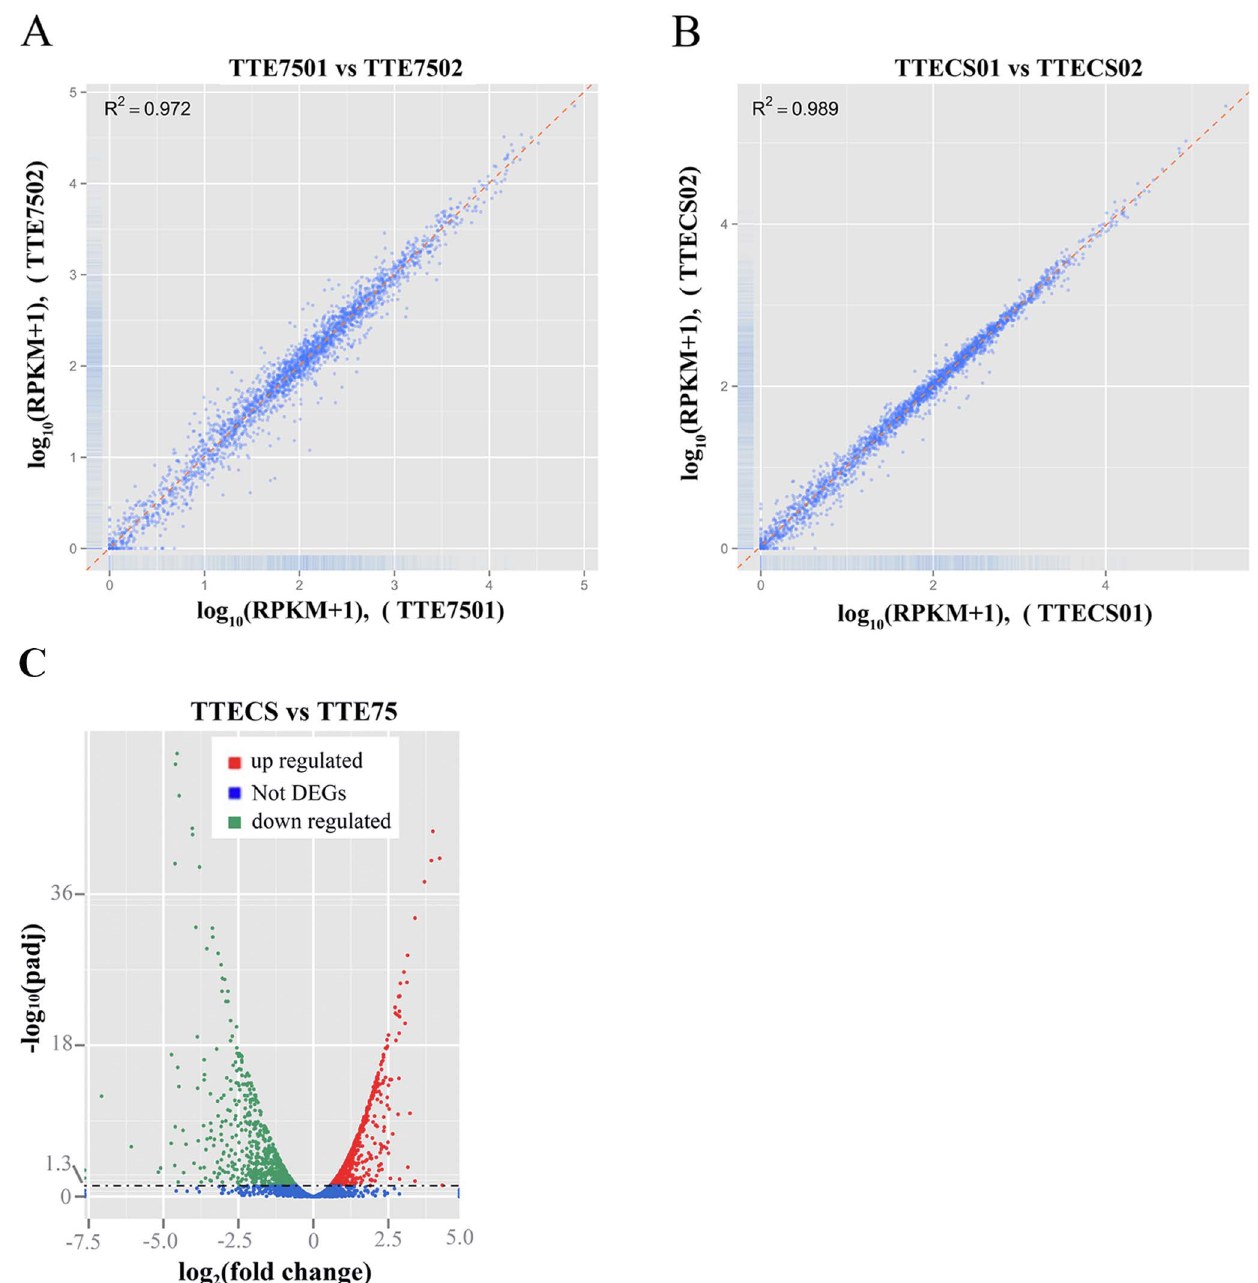
Figure 2. Comparison of gene expression between biological samples with and without cold shock. Scatterplot matrix comparison of gene expression in two biological replicates of TTE75 (A) and TTECS (B). C. Change level of global differential expression genes between TTECS and TTE75.